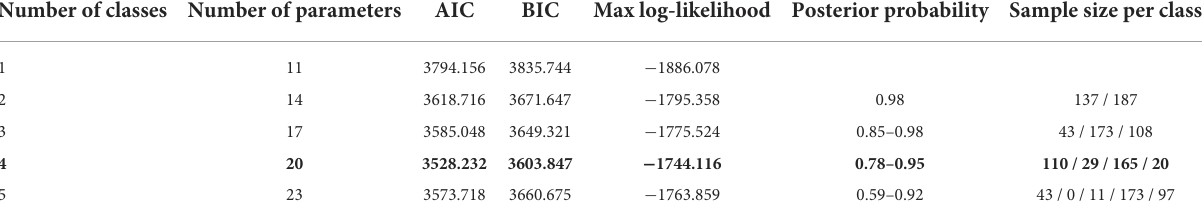
TABLE 1 Model Fit Parameters for LCMM of numbers of cigarettes smoked with One to Five Classes. Number of classes Number of parameters